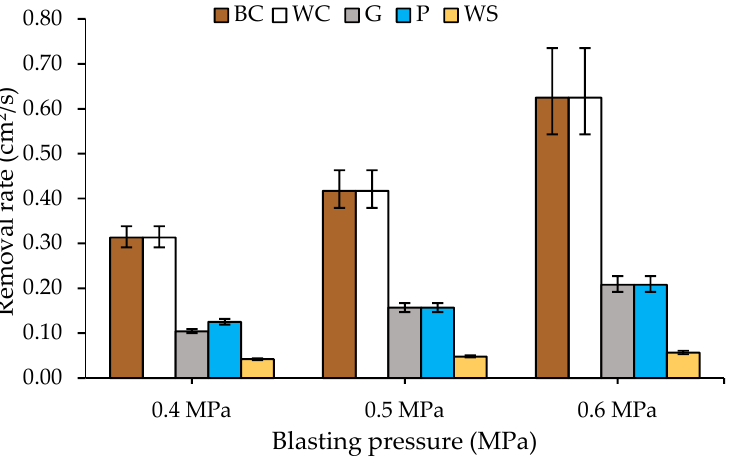
Figure 3. Stripping rate on PTFE coatings on EN AW-5182 substrate vs. spray pressure with different abrasives: (i) BC-brown corundum, (ii) WC-white corundum, (iii) G-glass microspheres, (iv) P-plastic particles, and (v) WS-walnut shell.